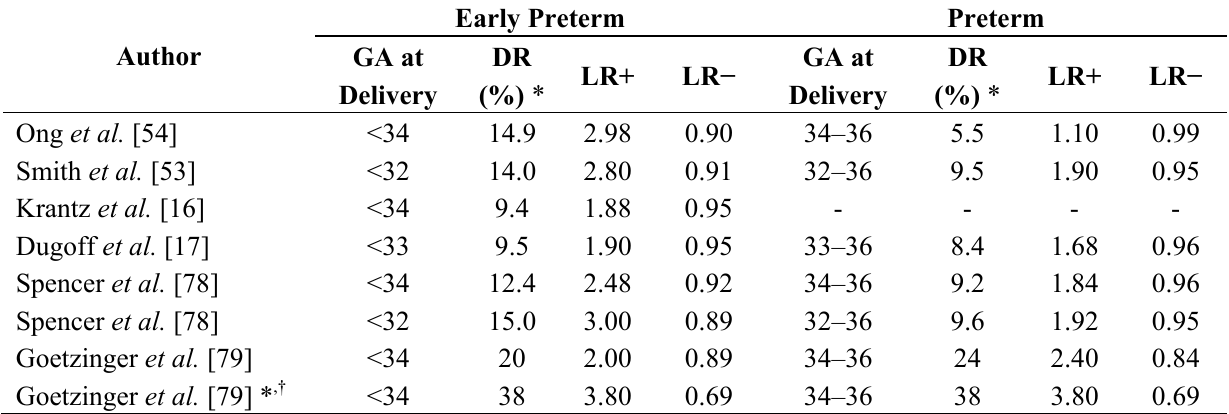
Table 2. Performance of PAPP-A in predicting early pre-term and pre-term